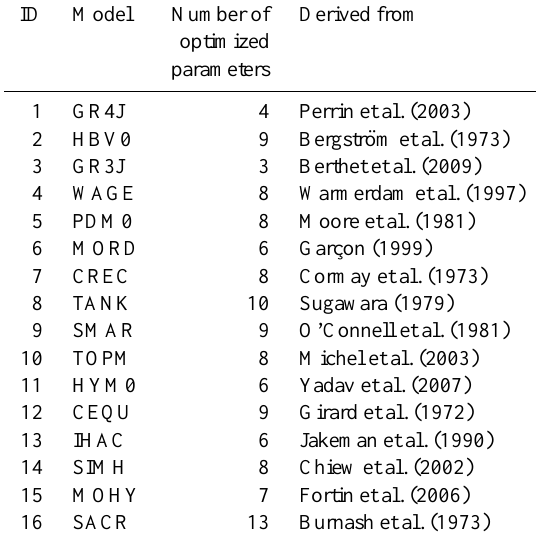
Table 2. Models studied, with their identification number, number of optimized parameters and main